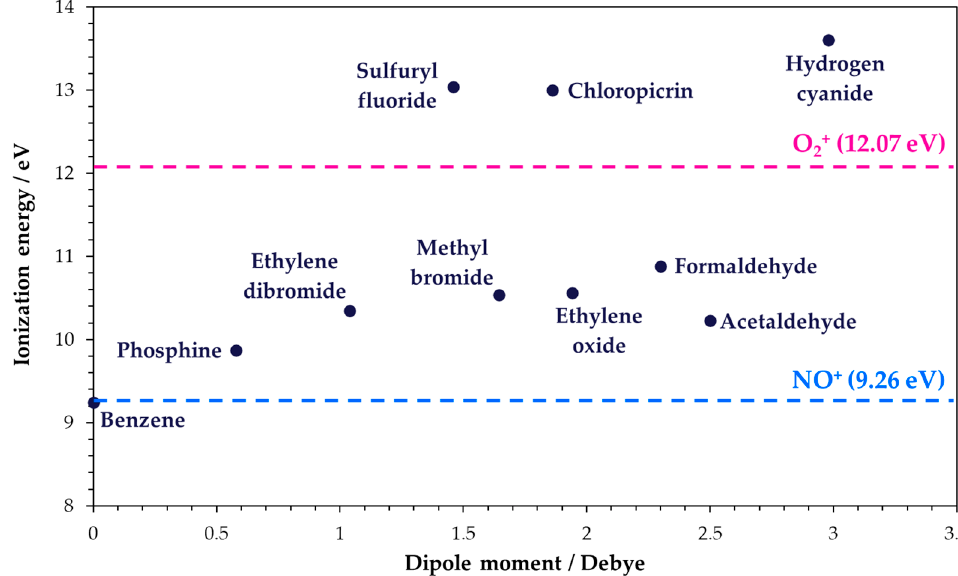
Figure 4. Illustration of the diversity of gaseous fumigants and several TICs based on their polarity (as indicated by the dipole moment) and ionization energy (in electron volts, eV). The ionization energies of NO and O 2 , corresponding to the NO + and O 2+• reagent ions of SIFT-MS, are shown for reference.